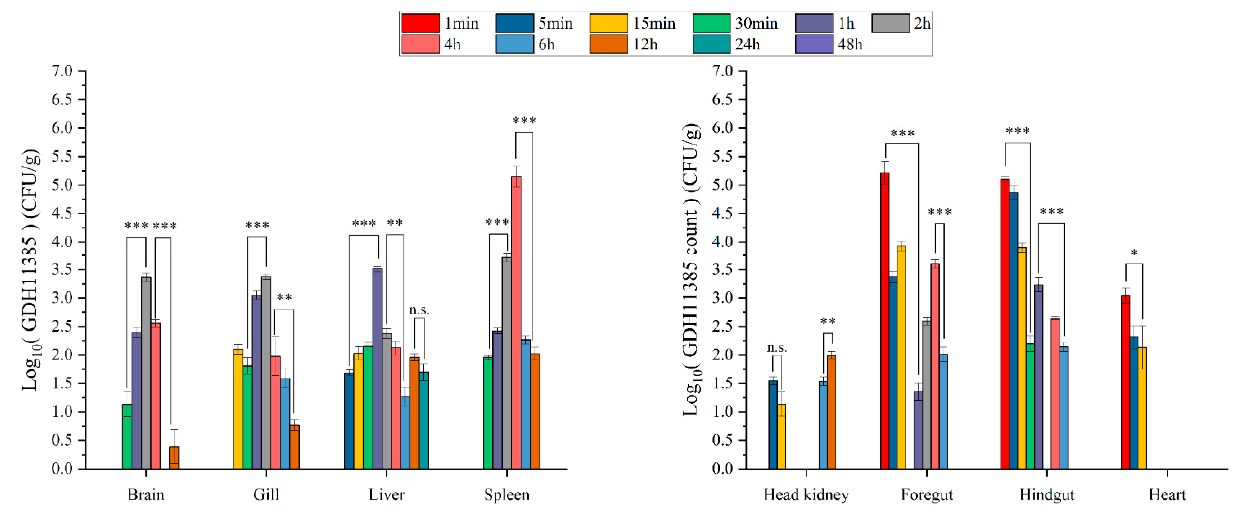
Figure 3. The distribution of GDH11385 in brain, liver, spleen, head kidney, gills, foregut, hindgut and heart of coinfected hybrid groupers (group D) over 48 h postinjection. Data are shown as mean ± SD of three independent biological replicates. n.s., not significant; * p < 0.05, ** p < 0.01, *** p < 0.001. In the progression of coinfections with strain GDH11385 and three isolated patho- gens, strain GDH11385 was first detected in the foregut and hindgut at 1 mpi, in the spleen and head kidney at 5 mpi, in the brain and gills at 15 mpi and in the liver at 2 hpi (Figure 4). The trend of GDH11385 load in the intestine at the initial stage of infection was con- sistent with the progression trend in monoinfection, while the load of GDH11385 in- creased in the brain, liver, spleen, head kidney, gills and heart at 1–2 hpi. Based on the above results (Figure 5A,B), the load of strain GDH11385 was more enriched in some or- gans such as the intestine (foregut and hindgut), liver and spleen during the progress of coinfection and monoinfection.